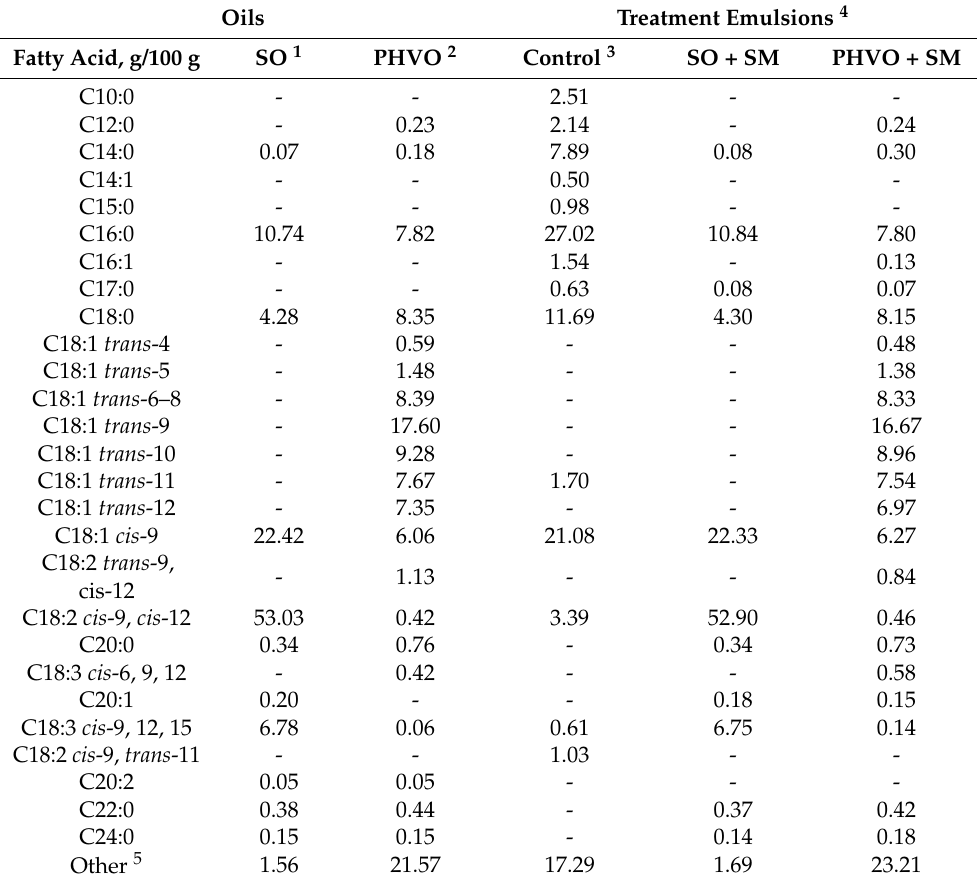
Table 2. Fatty acid composition of oils, skimmed milk and emulsions used for ruminal pulses. Oils Treatment Emulsions